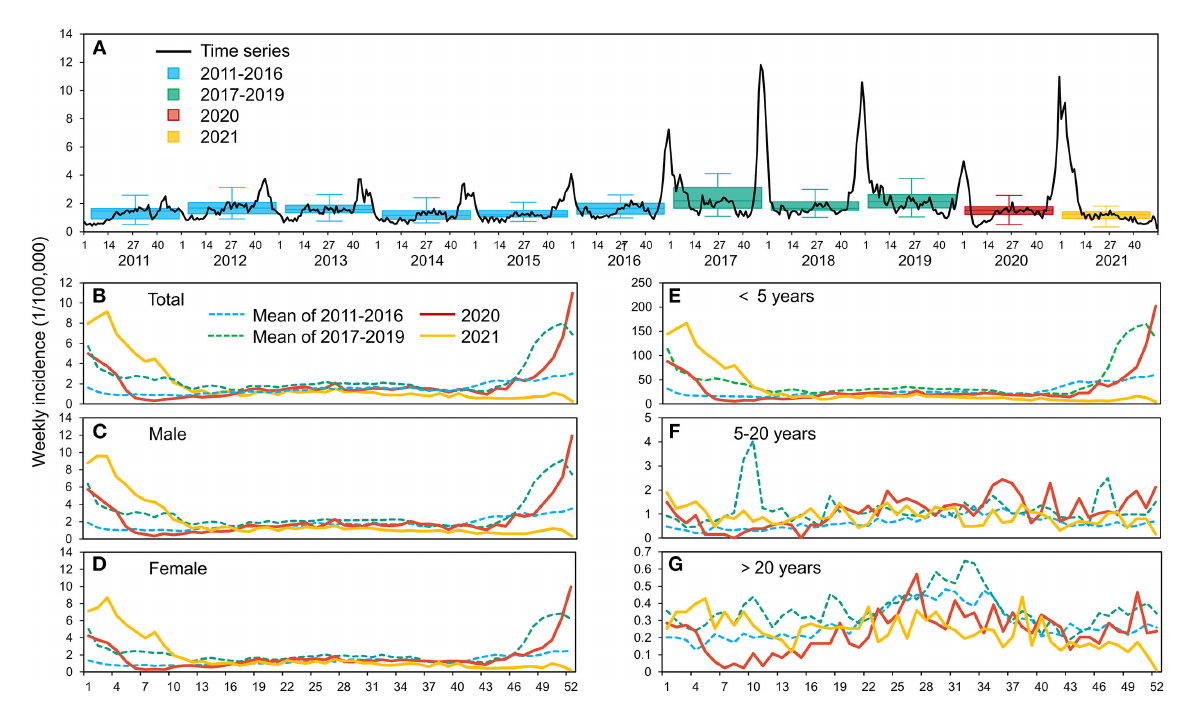
FIGURE1 Weekly incidence of infectious diarrhea in Xi’an from 2011 to 2021 (A) , and average weekly incidences during four different time periods with stratification by sex (B–D) and age (E–G) .